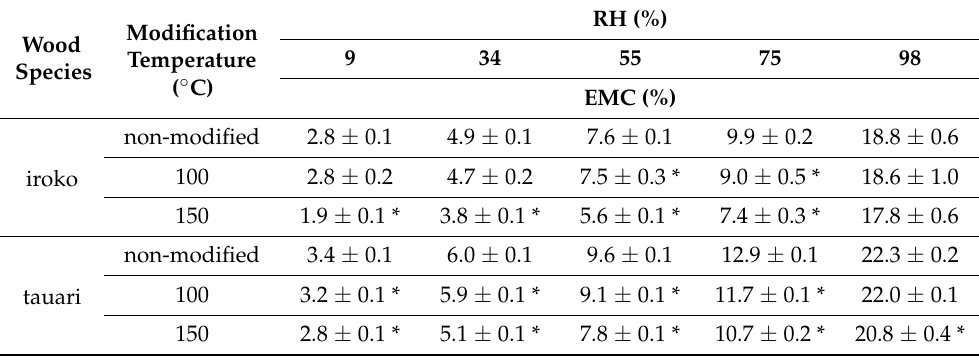
Table 6. Equilibrium moisture content (EMC) of thermo-mechanically modified wood at different relative humidity (RH); ±